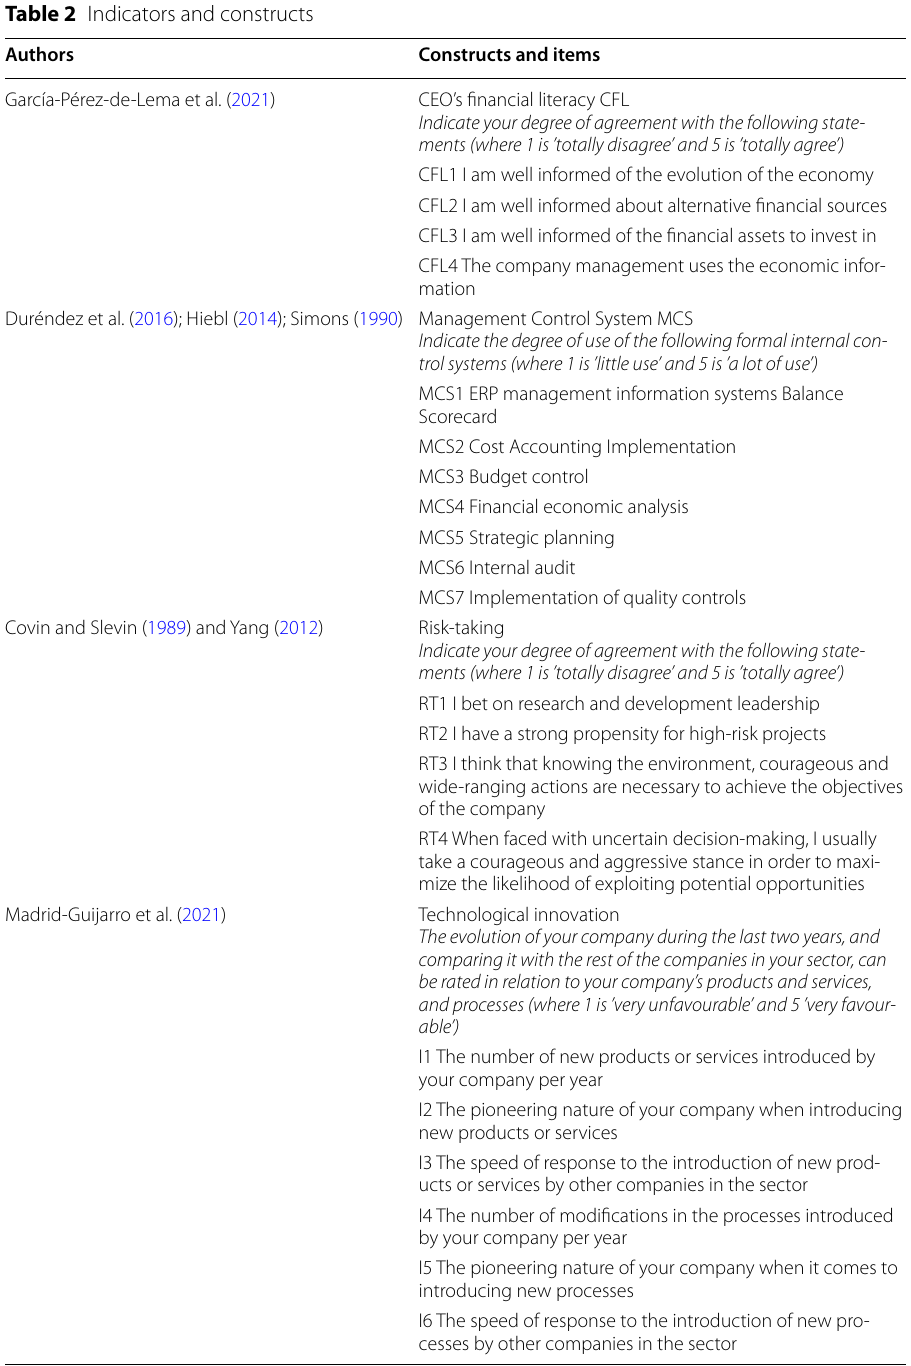
Table 2 Indicators and constructs Authors Constructs and